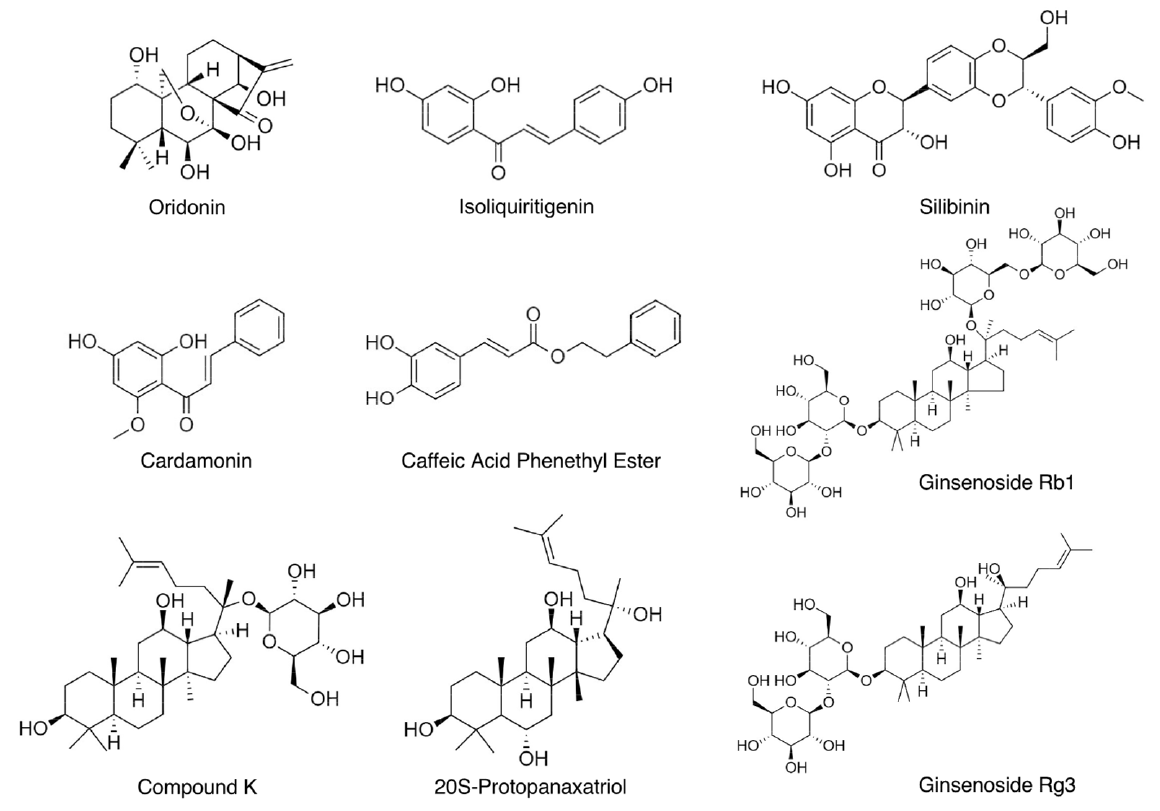
Figure 2. Chemical structures of anti-NLRP3 inflammasome natural compounds.